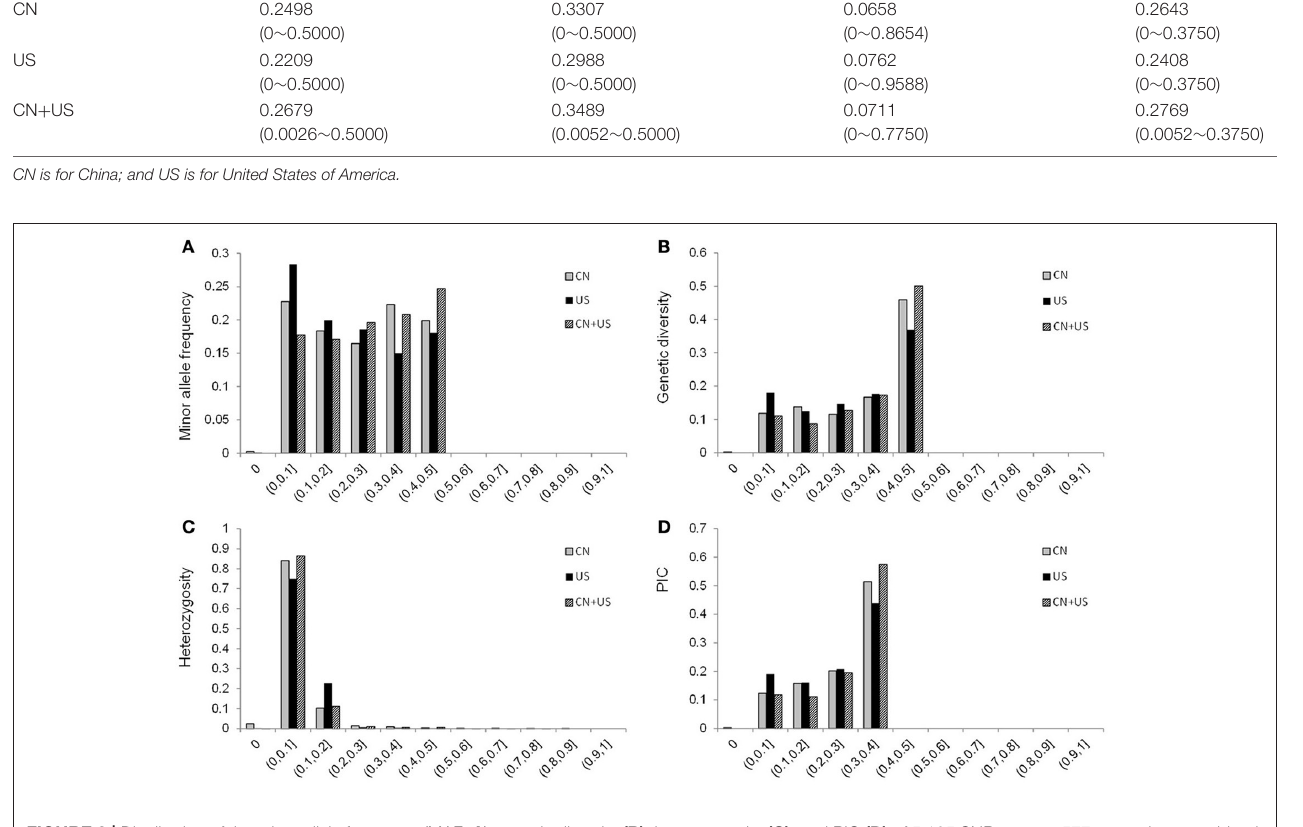
FIGURE 2 | Distribution of the minor allele frequency (MAF; A ), genetic diversity (B) , heterozygosity (C) , and PIC (D) of 5,195 SNPs across 577 accessions combined, for 277 accessions from China, and for 300 accessions from the USA. CN is for China; US is for United States of America; and CN + US is for China and US accessions analyzed together.